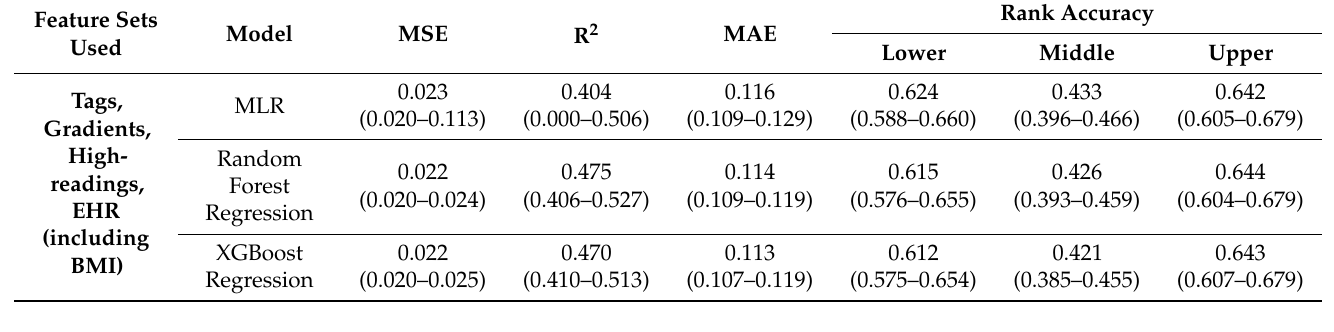
Table A7. Results of models trained on all features, including BMI, using the reduced dataset (362 patients in training set, corresponding to 2500 windows in test set; 90 patients in testing, corresponding to 601 windows).